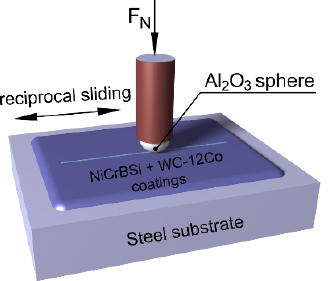
Figure 3. Scheme of the tribological test.